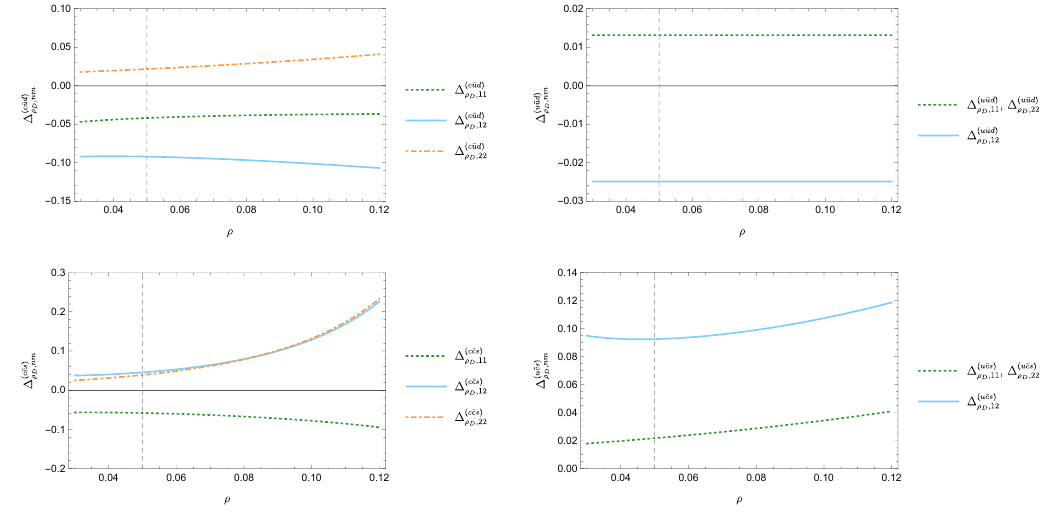
Figure 6 . The Darwin term correction normalised to the partonic-level coefficient for different modes, namely b → c ¯ ud (top left), b → u ¯ ud (top right), b → c ¯ cs (bottom left), and b → u ¯ cs (bottom right). The green dotted line corresponds to Q 1 ⊗ Q 1 , the solid cyan line to Q 1 ⊗ Q 2 and the dotted-dashed orange line to the Q 2 ⊗ Q 2 contribution. For reference we have fixed the values µ 0 = m b , m b = 4 . 5 GeV and ρ 3 = 0 . 2 GeV 3 . The dashed vertical line shows the approximate value D ρ = 0 . 05 in the MS